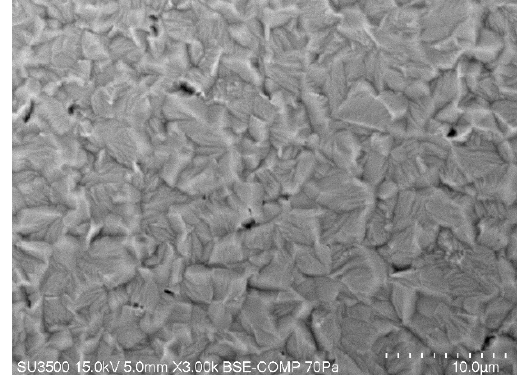
Figure 1. The SEM picture of the CdS 0.95 Te 0.05